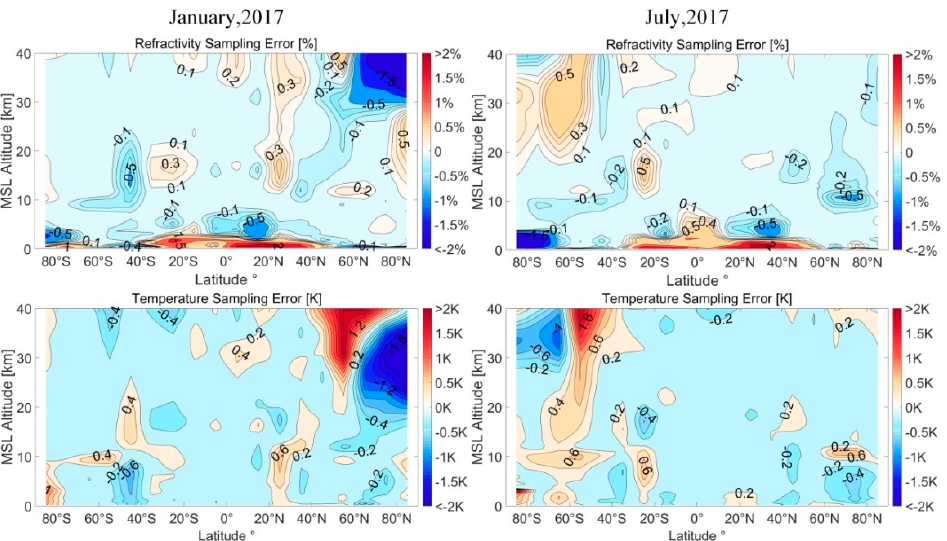
Figure 9. Refractivity and temperature sampling errors for January (left panels) and July (right panels) of 2017 with 10° latitudinal interval bands.